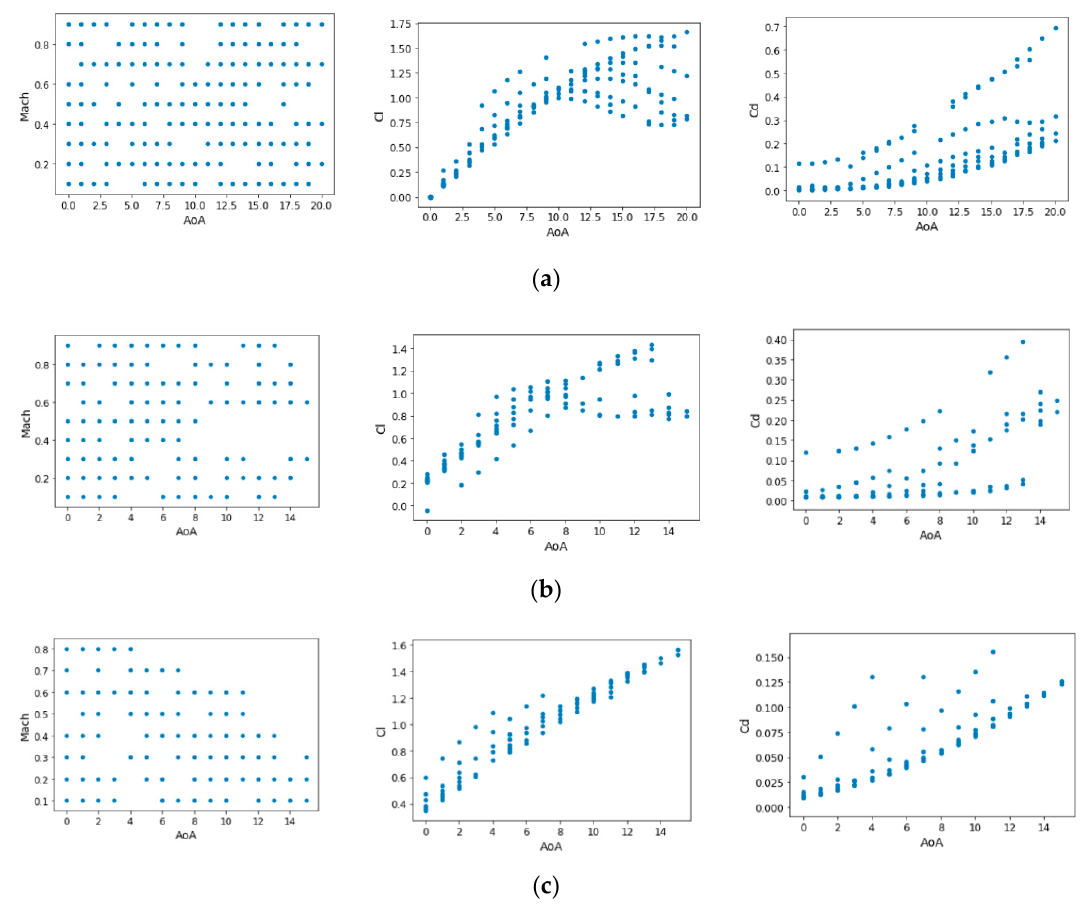
Figure 5. Training set in the NACA0012 ( a ), RAE2822 ( b ) and DPW ( c ) databases (left: Mach versus AoA distribution of the database samples, middle: lift coefficient curves of the database samples, right: drag coefficient curves of the database samples).